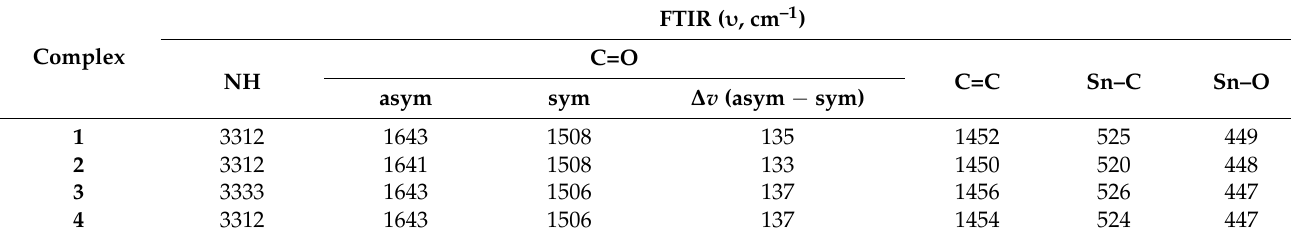
Table 2. FTIR data of 1 – 4 .